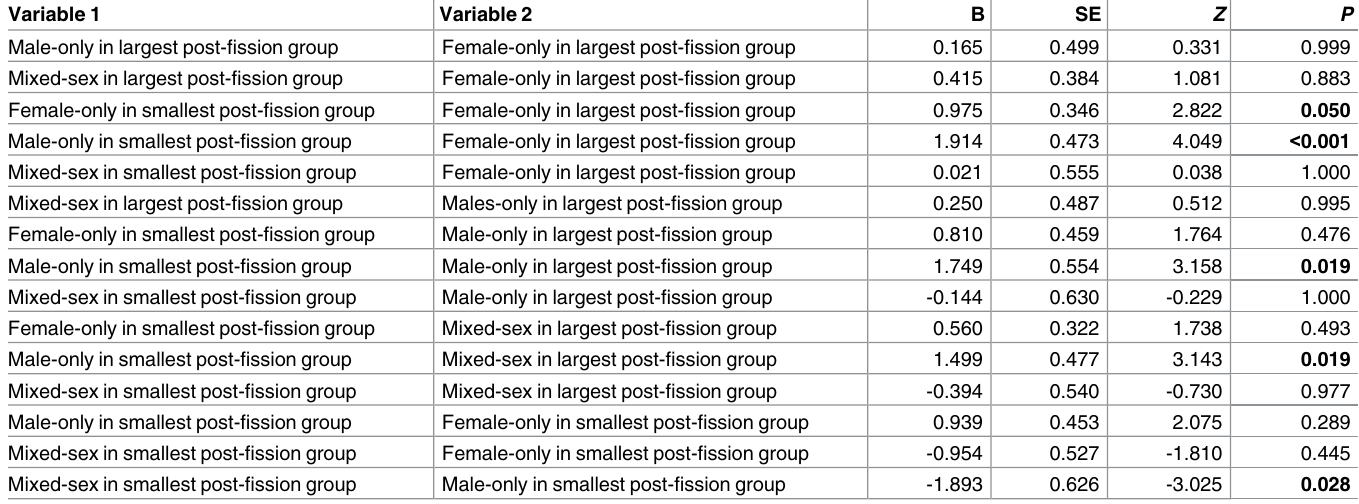
Table 3. Statistics of multiple comparisons (Tukey contrats) on the Ln(NDR) between groups from the linear-mixed effectsmodel 9d (see Table 2). The generallinear hypothesisis variable1 –variable2 = 0. Significantdifferences are in bold. Variable